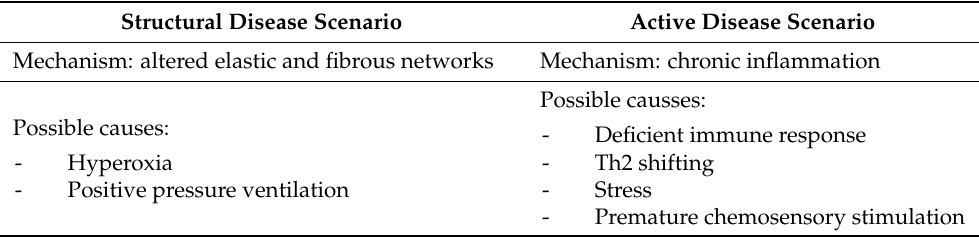
Table 2. Physio-pathologic scenarios in wheezing disorders of premature babies [54,55]. Structural Disease Scenario Active Disease Scenario Mechanism: altered elastic and fibrous networks Mechanism: chronic